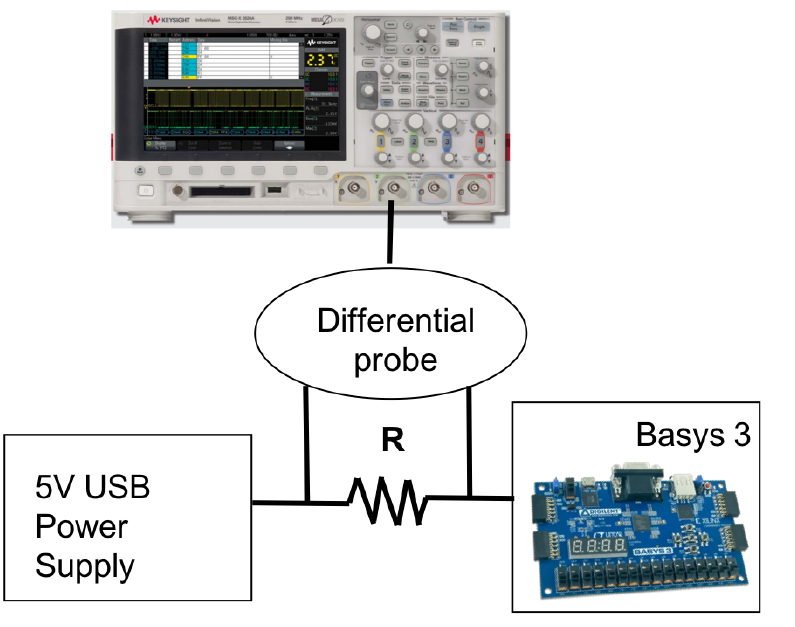
Figure 9. Power measurement setup.